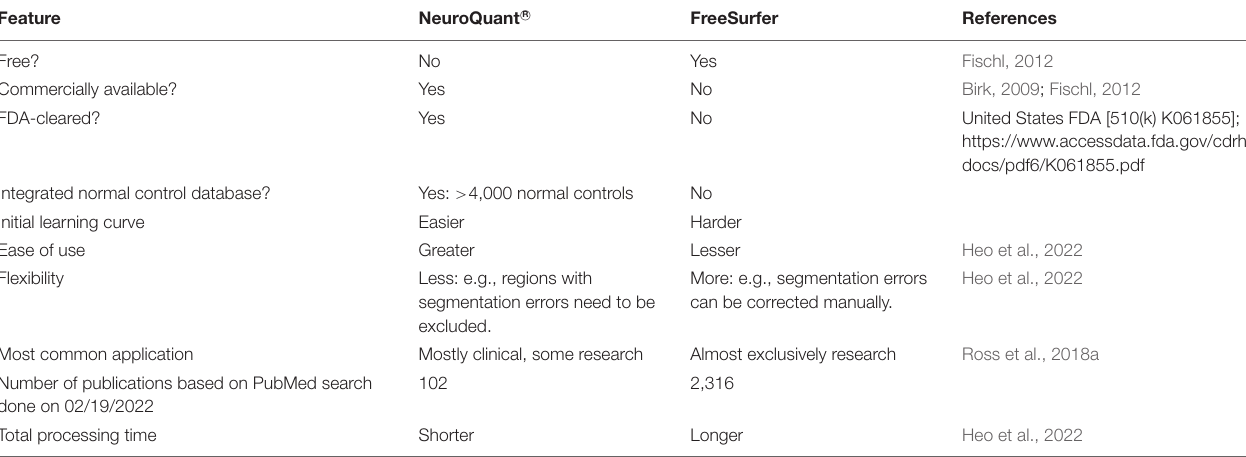
TABLE 1 | Comparison of NeuroQuant R (cid:13) and FreeSurfer computer-automated MRI brain volumetry software